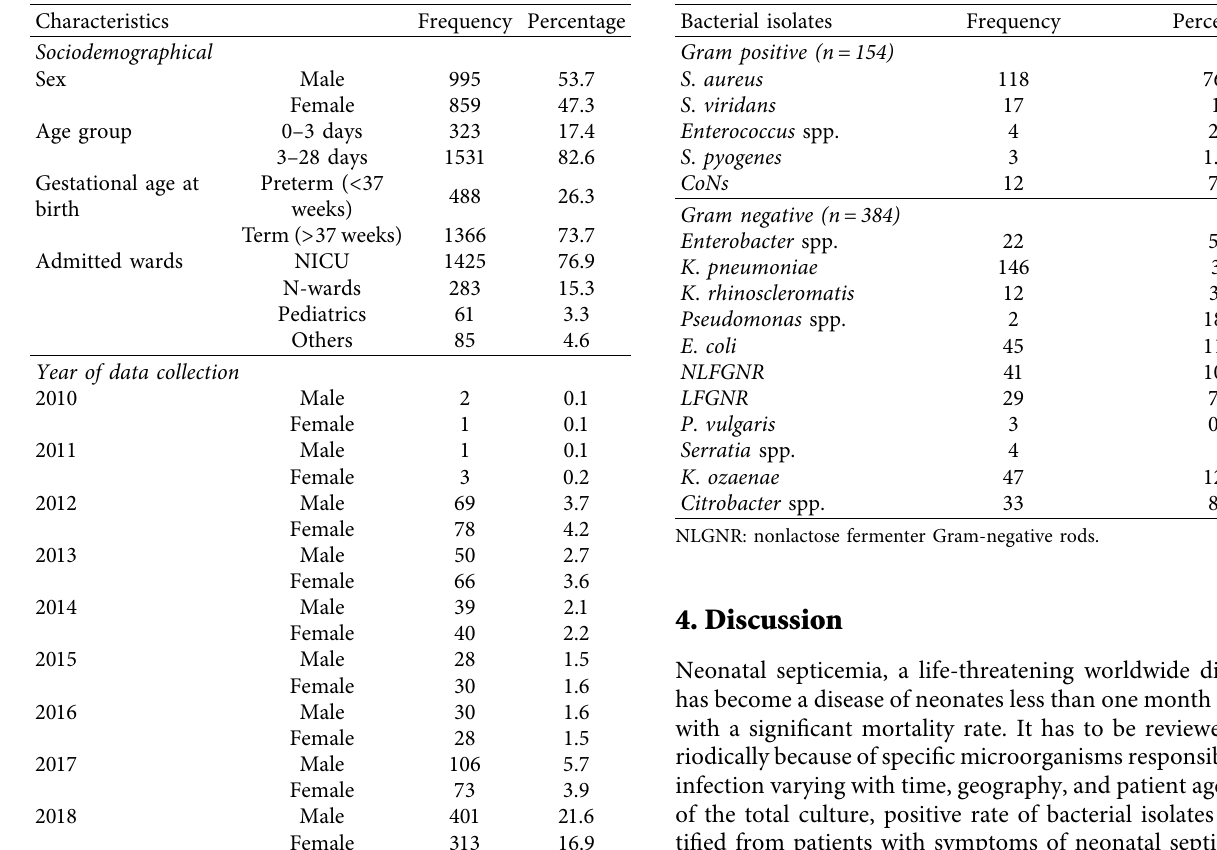
Table 2: Percentage and frequency of bacterial isolates among neonates having sepsis at University of Gondar Comprehensive Specialized Referral Hospital, Gondar, Northwest Ethiopia, 2021.